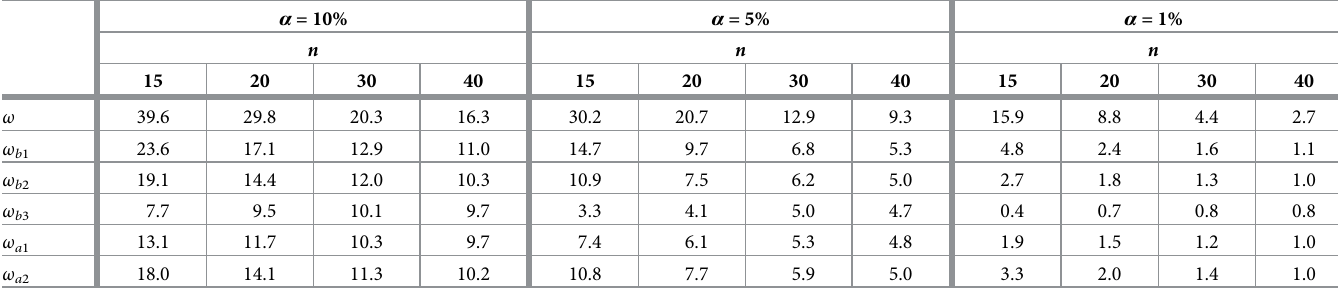
: d ¼ d ¼ 0 . 0 2 3